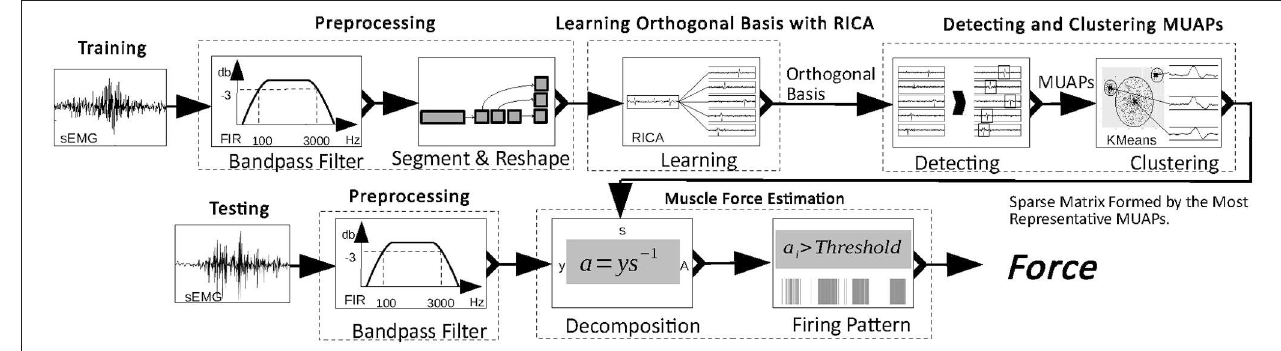
FIGURE 1 | Workflow of the proposed muscle force estimation